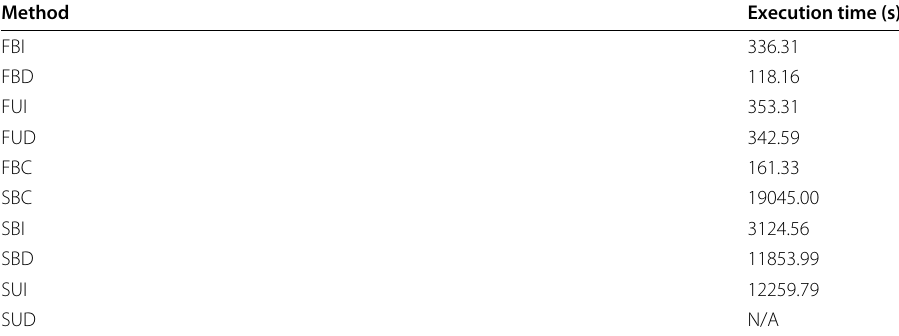
Table 4 Execution time for different variations of Algorithm 1, for 12 nodes, MNIST data set